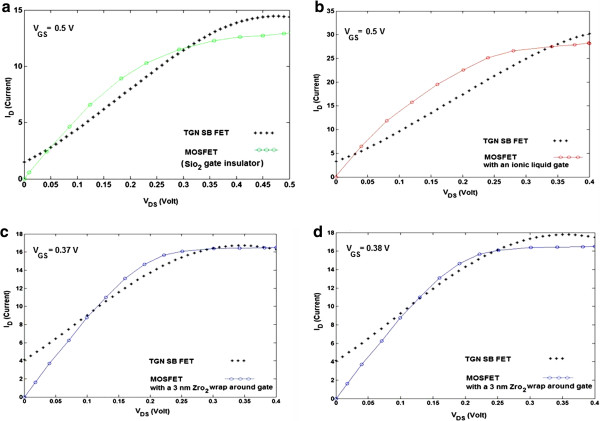
Comparison between proposed model and typical I-V characteristics of other types of transistors. (a) MOSFET with SiO2 gate insulator [50] (VGS = 0.5V), (b) TGN MOSFET with an ionic liquid gate, Cins >> Cq[49] (VGS = 0.5 V), (c) TGN MOSFET with a 3-nm ZrO2 wrap around gate, Cins~ Cq[49] (VGS = 0.37 V), (d) TGN MOSFET with a 3-nm ZrO2 wrap around gate, Cins ~ Cq[49] (VGS = 0.38 V).